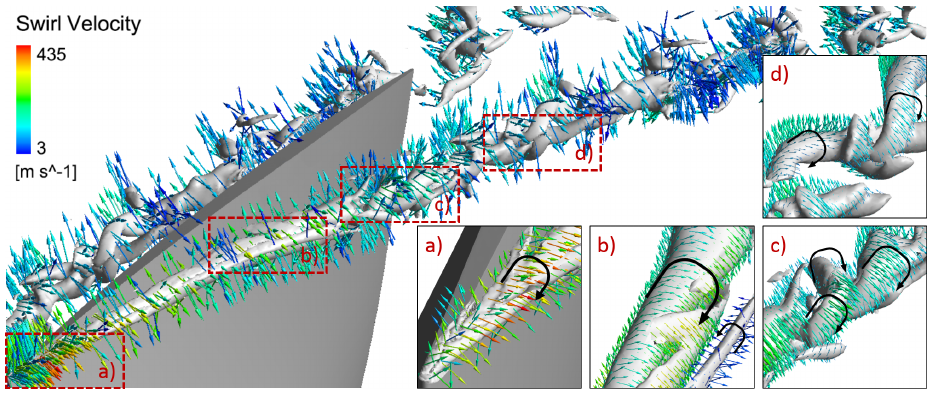
Figure 21. Swirl velocity vector on the λ 2 isosurface.